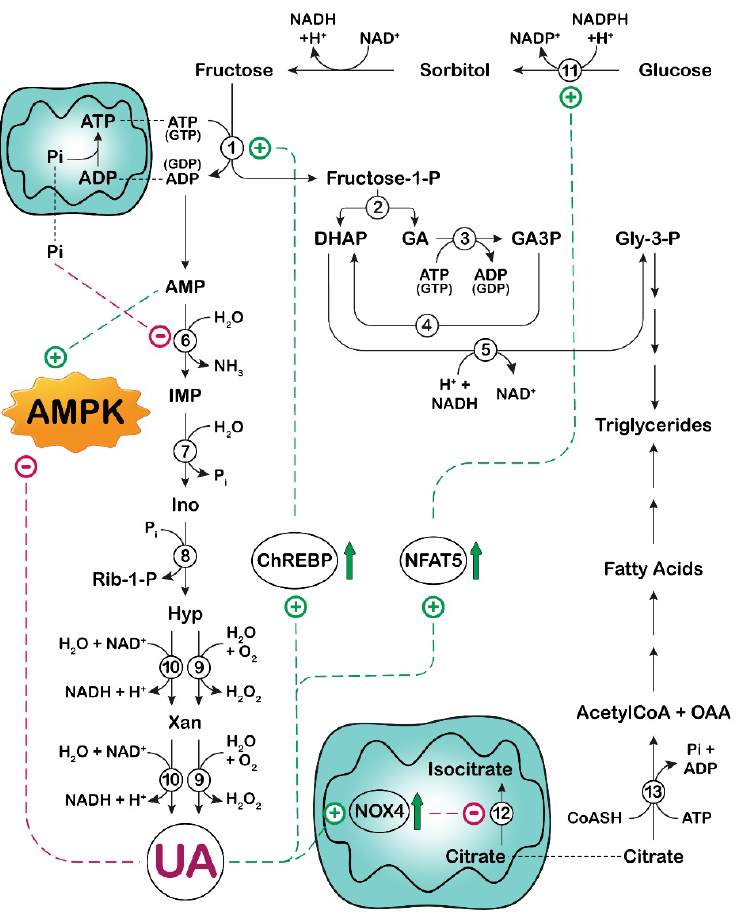
Figure 2. Effect of UA on fructose metabolism in liver. Phosphorylation of fructose in liver is catalyzed by fructokinase (enzyme 1), which is not subjected to feedback inhibition and phosphorylates fructose as rapidly as it can, leading to intracellular ATP and phosphate depletion. The formed fructose-1-phospahte is cleaved by aldolase B (enzyme 2) into dihydroxyacetone phosphate (DHAP) and glyceraldehyde (GA). GA is phosphorylated to glyceraldehyde-3-phosphate (GA3P) (triokinase, enzyme 3), which can enter the glycolytic pathway or can be converted by triose phosphate isomerase (enzyme 4) into DHAP. In turn, DHAP, by glycerol-3-phosphate dehydrogenase (enzyme 5), is reduced to glycerol-3-phosphate (Gly-3-P), which contributes to the synthesis of triglycerides. As a consequence of ATP catabolism, AMP is generated. The deamination of AMP, catalyzed by AMP deaminase (enzyme 6), is accelerated, and AMP is channeled towards IMP, which is hydrolyzed by cytosolic-5’-nucleotidase II (enzyme 7) to inosine (Ino). In turn, Ino is phosphorolytically cleaved into hypoxanthine (Hyp) and ribose-1-phosphate (Rib-1-P) by purine nucleoside phosphorylase (enzyme 8). Rib-1-P can be mutated to ribose-5-phosphate and then converted to 5-phosphoribosyl-1- pyrophosphate (see Figure 3), thus contributing to the increase in purine de novo synthesis. Hyp, through the action of xanthine oxidoreductase (oxidase, enzyme 9 or dehydrogenase, enzyme 10), is converted to UA. UA exerts an inhibitory effect on AMPK (see Figure 4) and an activatory effect (through stimulation of ChREBP) on fructokinase (enzyme 1). UA also activates aldose reductase (enzyme 11) (through stimulation of NFAT5), enabling endogenous fructose production from glucose. In addition, UA promotes the translocation of NADPH oxidase 4 (NOX4) from cytosol to mitochondria, which increases mitochondrial ROS generation with inactivation of aconitase (enzyme 12). Citrate is released by the mitochondrion and then converted back, by cytosolic ATP-citrate lyase (enzyme 13), to acetyl-CoA, necessary for the synthesis of fatty acids and triglycerides.